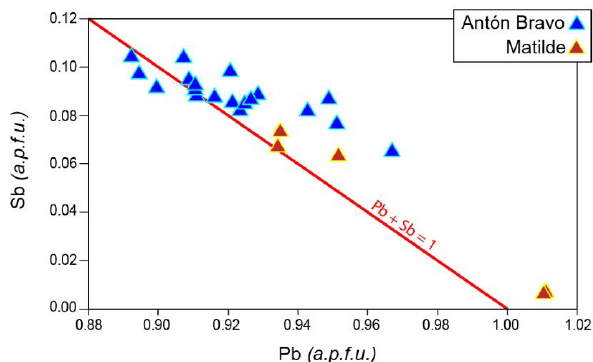
Figure 12. Pb vs. Sb binary plot for galena from the Huari Huari district.